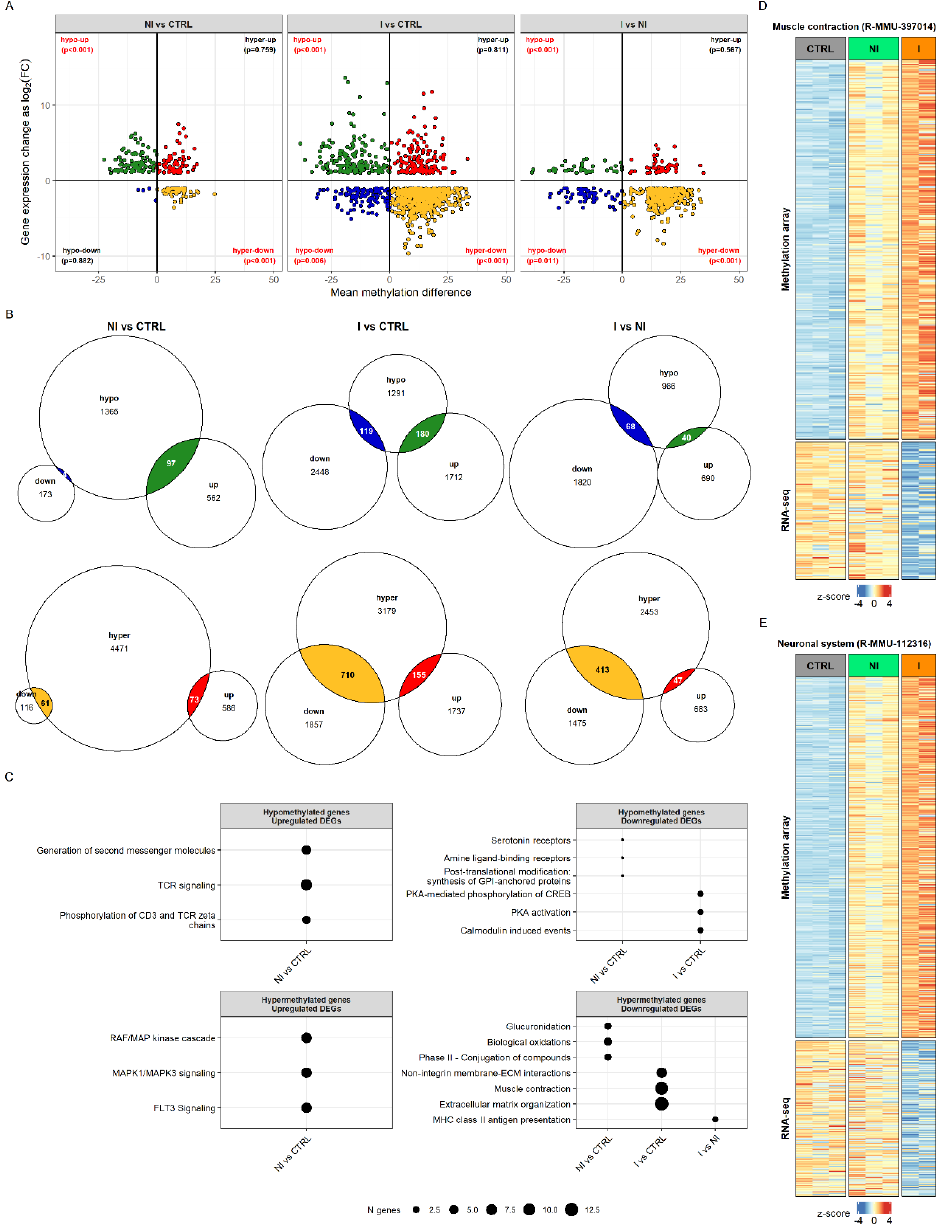
Figure 4. The relationship between DNA methylation and gene expression in BBN-induced bladder tumors in mice. ( A ) Scatter plot of mean methylation difference versus log 2 expression change by applying cut off |mean methylation difference| > 3 and |log 2 fold change| > 1, FDR adjusted p -value < 0.05; p -values obtained with hypergeometric tests. ( B ) Venn diagrams summarizing the intersection between differentially expressed genes (DEGs) and differentially methylated regions (DMRs). ( C ) Top Reactome pathways enriched in different comparisons (NI vs. CTRL, I vs. CTRL, and I vs. NI) based on the intersection between DEGs and DMRs. ( D ) Clustering of samples according to DNA methylation and gene expression levels of genes annotated to Reactome muscle contraction and ( E ) neuronal system pathways . I, invasive; NI, non-invasive; CTRL, control. To assess the biological significance of gene sets that shared methylation and tran- scriptional status per each sample group, we performed gene over-representation analysis